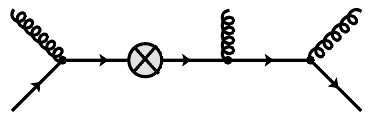
Figure 1 . Example renormalisation counter-term diagram contributing to t ¯ t + 3 g one-loop